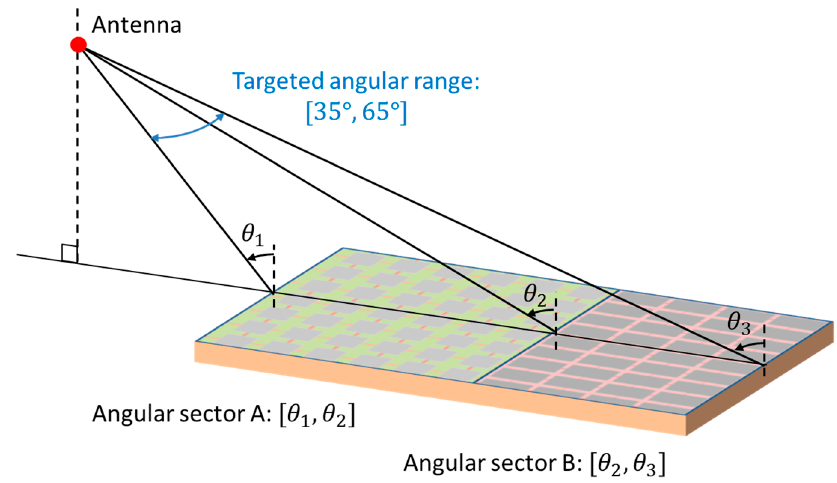
Figure 1. Angular range targeted for the present study. The platform is separated in two sectors for which the absorber can be optimized on a narrower range of incident angles.